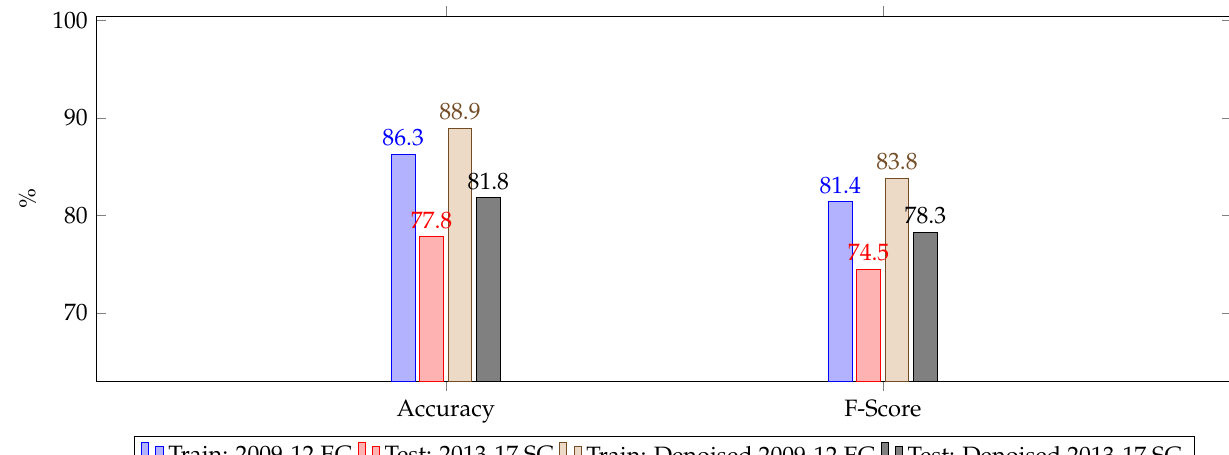
Figure 13. Accuracy and F-score obtained by training on 2009–2012 dataset and testing on 2013–2017